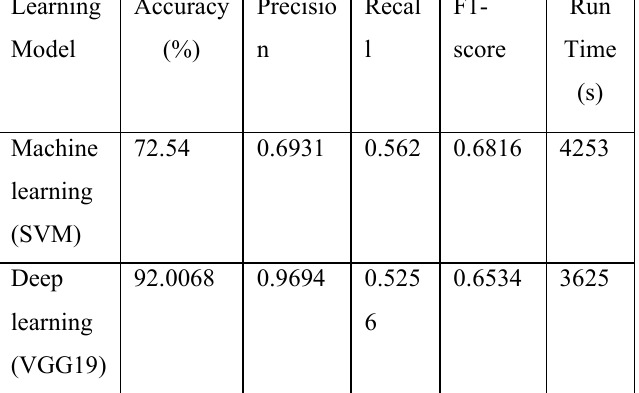
Table 1 compares the evaluation outcomes for